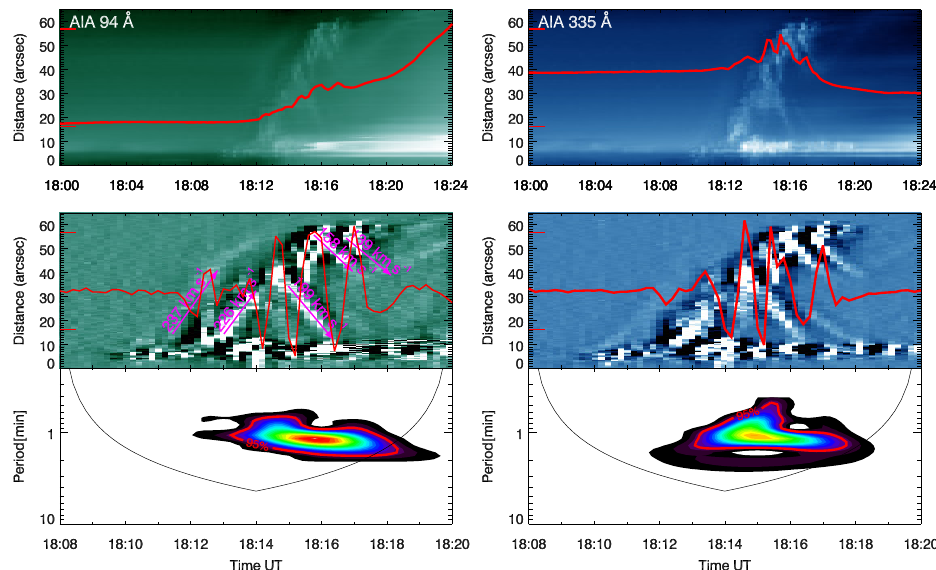
Figure 8. Top panels: time-distance diagrams of the S2 marked in Figure 3h at AIA 94 ˚A ( left ) and AIA 335 ˚A ( right ), and the red curves represent the light curves between two horizontal red lines on Y-axis. Middle panels: the smooth-subtracted images of top panels. Red curves represent the fast-varying components between two horizontal red lines on Y-axis. The arrows and numbers label the velocity of jets and the falling matter. Bottom panels: the wavelet spectra of the red curves. The red contours represent a significance level of